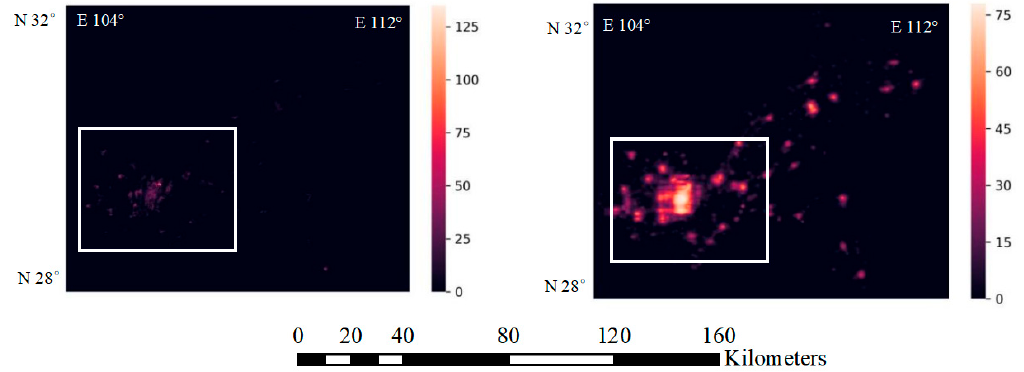
Figure 6. Comparison of a 2020 NTL image before ( left ) and after ( right ) calibration. The fractured and unconnected segments representing the raw NTL data now show up as a smooth and unbroken line (Figure 7). Starting with the minimal DN sum value of 47,617, the calibrated data increased steadily from 1992 to 2005, remaining relatively stable between 2005 and 2010. It had a slight decline in 2007 when the value dropped from 212,327 to 201,520, and then it bounced back to an upward trend from 2010 to 2020, which precisely matched the trend of the raw data. Between 2007 and 2010, there is a slight fluctuation due to the DMSP/OLS sensor problem [39], which is also reflected by the calibrated data. After that, the NTL TDN reached the maximum value of 347,233 in 2020 with the same upward swing as the original VIIRS data. In general, the NTL data calibration process enabled the two types of data sources to be unified and the integrated data retained the same trend as the individual DMSP and VIIRS datasets.